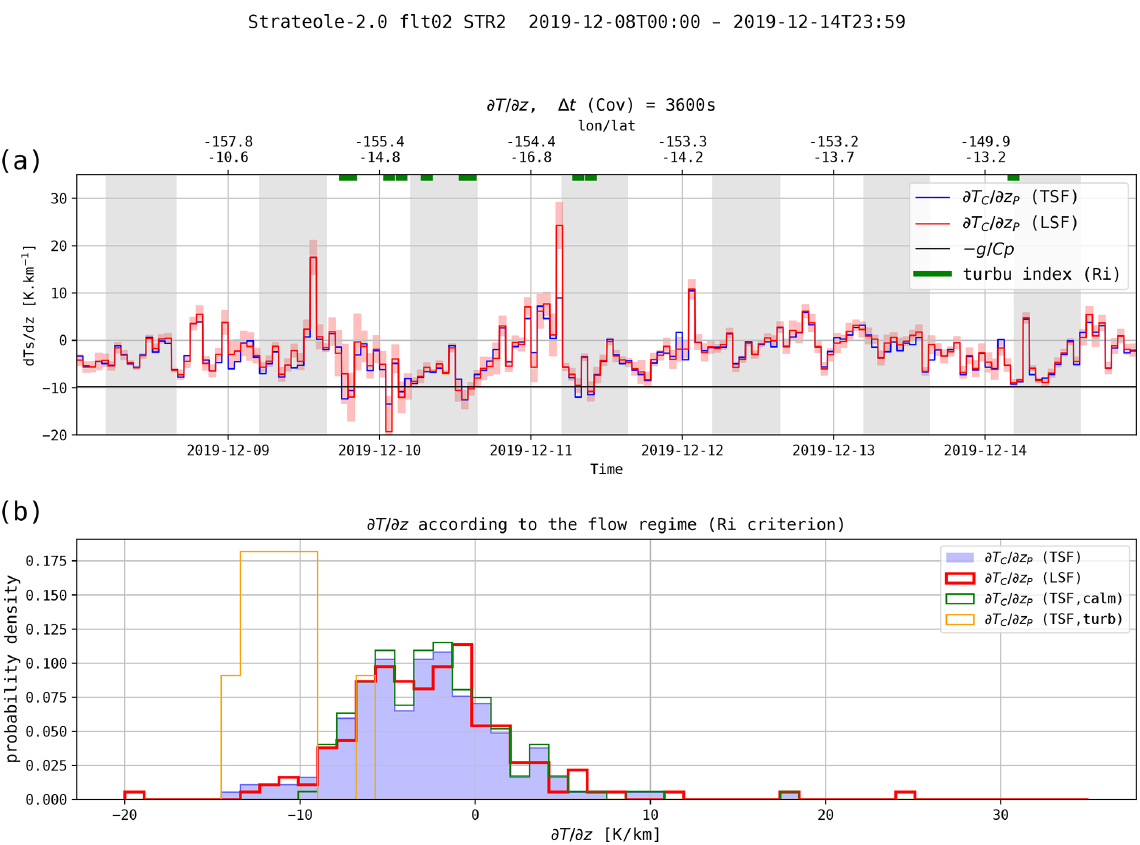
Figure 8. (a) Time series of ∂T/∂z estimated by two respective fitting methods, least squares fitting (LSF) and Theil–Sen fitting (TSF), from T C and z P . Linear fits are performed on 1h time segments (120 samples). The light red shaded areas show the ± 1 standard deviation interval for the LSF estimates. (b) Histograms of the temperature gradients from the two respective methods. The histograms corresponding to the turbulent and laminar time segments are also plotted (light curves).